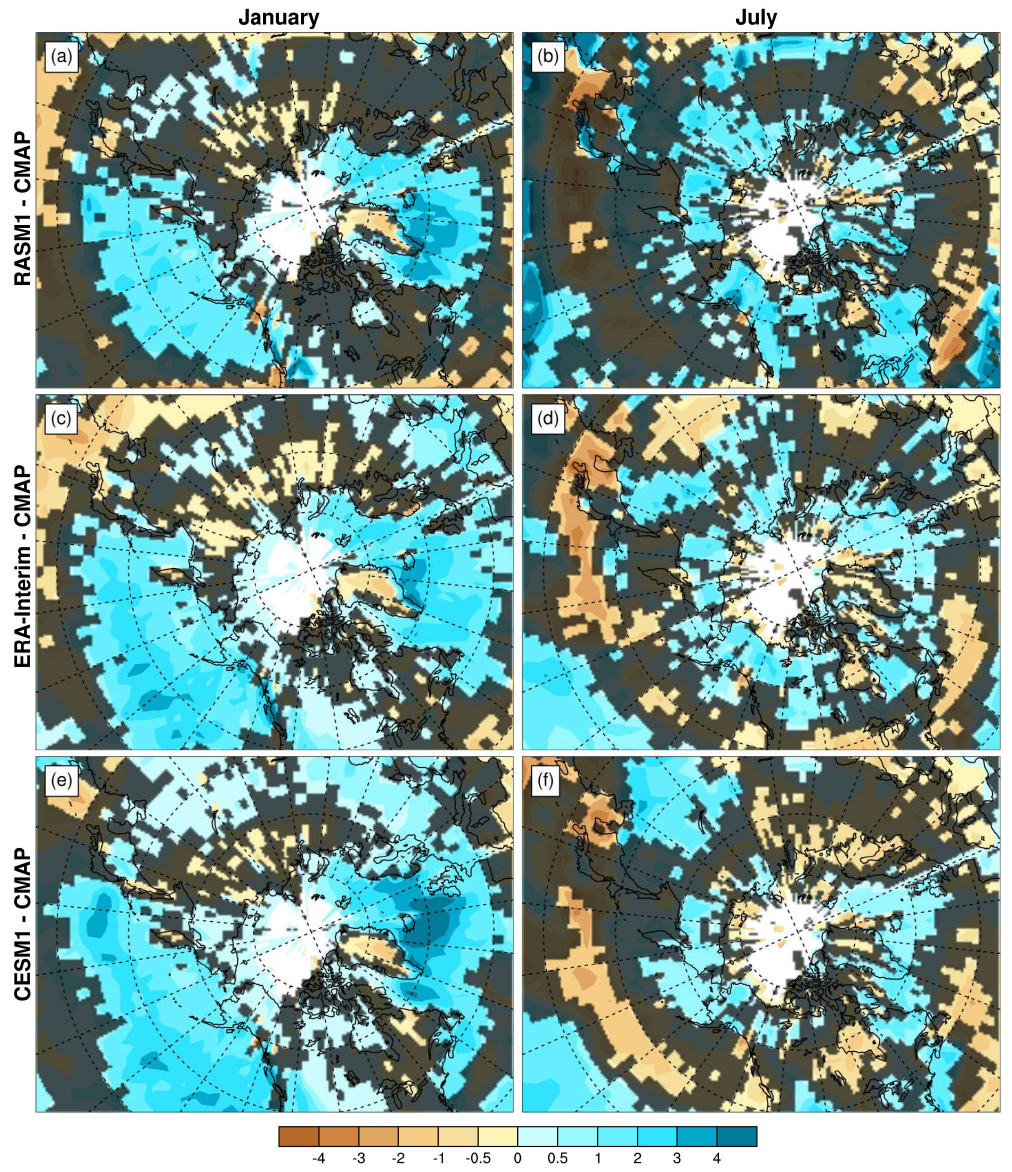
Figure 2. The bias in precipitation rate (mmday − 1 ) in (a, b) RASM1, (c, d) ERA-Interim, and (e, f) CESM1 from that of CMAP in January (left) and July (right) for 1990–2009. White areas are those in which CMAP contains missing data. The shading indicates grid cells with differences that are not statistically significant at the 95% level according to the Welch’s two-sided t